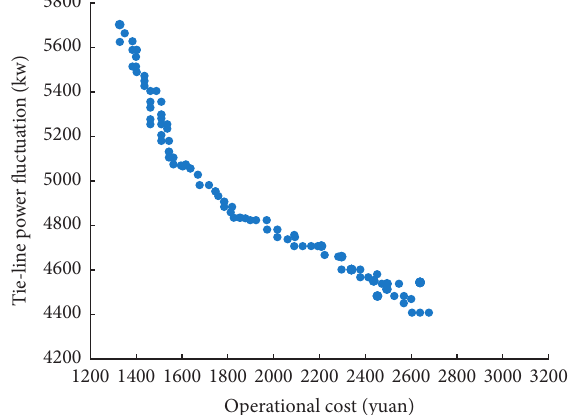
Figure 9: Pareto front of the source-grid-load level.